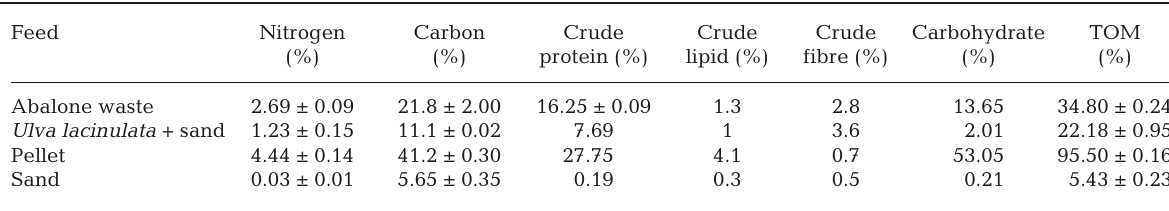
Table 1. The assay content of experimental feeds (abalone waste, Ulva lacinulata mixed with sand, pellet, and sand). TOM: total organic matter. Data are mean ±